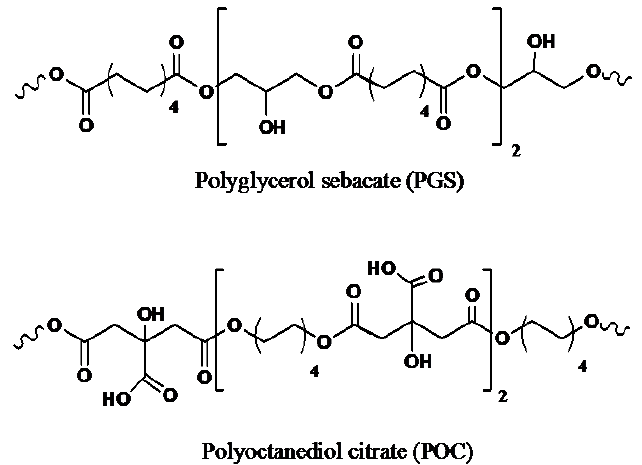
Figure 15. Chemical structures of linear poly(octanediol citrate) and poly(glycerol sebacate) with pendant hydroxyl and carboxyl